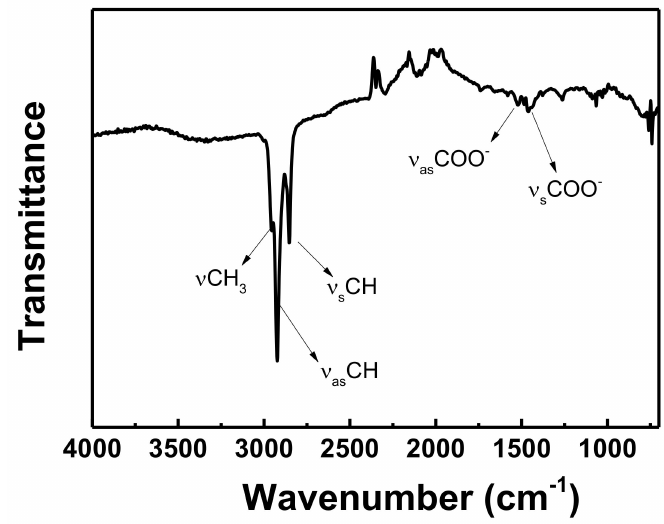
Figure 2. The FT-IR-ATR spectrum of TiO 2 NRs in the 4000–700 cm –1